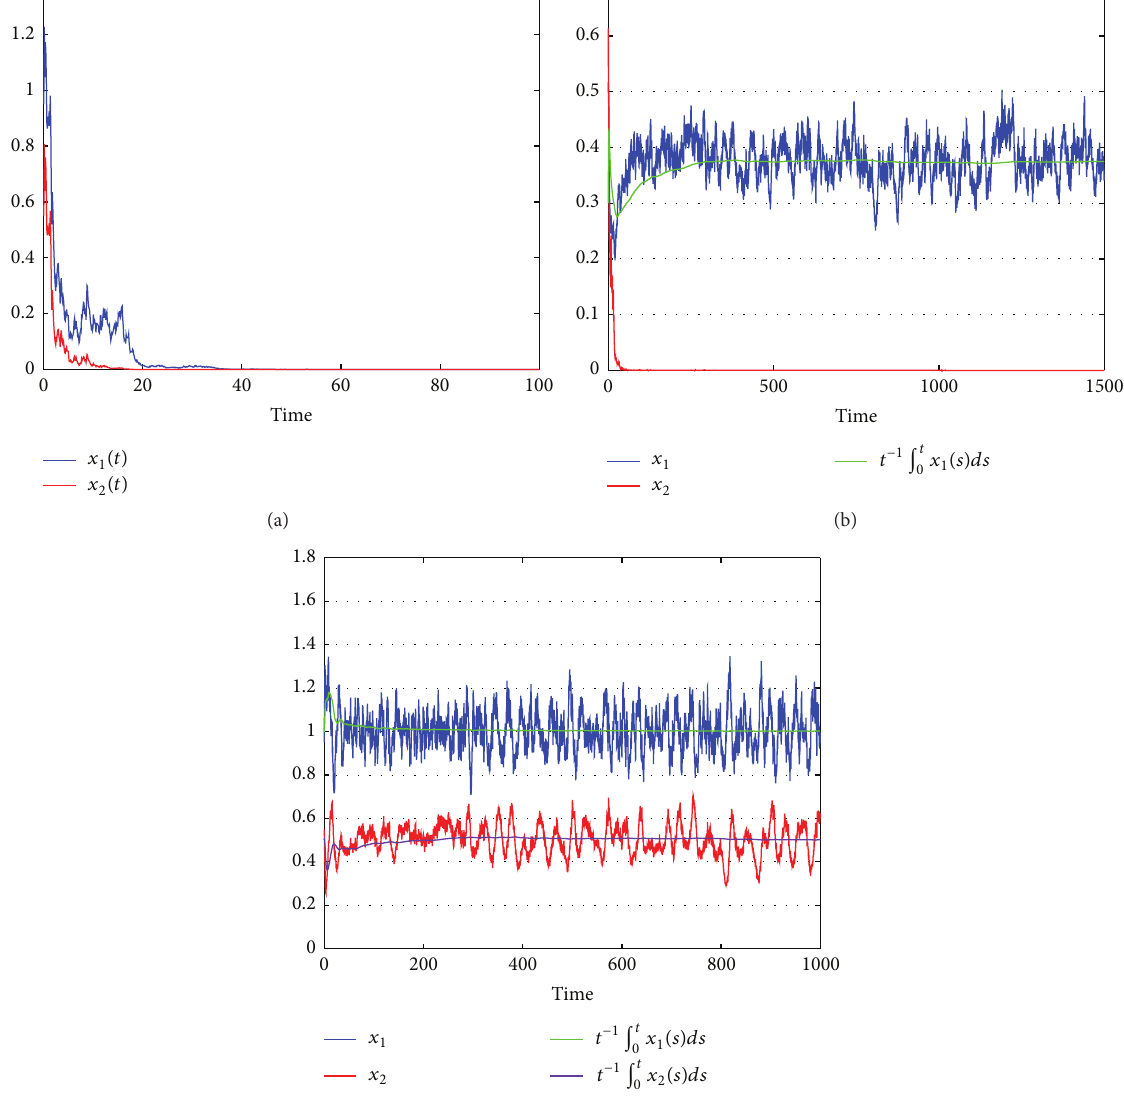
(0) = 0.9 , 𝑥 (0) = 0.5 , 𝐶 (0) = 𝐶 (0) = 0.1 , and step size Δ𝑡 = 0.001 . (a) is with 1 2 0 𝑒 /2 = 0.2 1